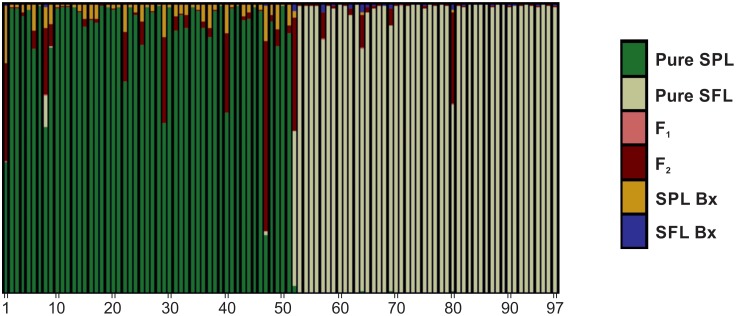
Estimated posterior probabilities that each individual from the sympatric populations of L. planeri (SPL; n = 52) and L. fluviatilis (SFL; n = 46) belongs to each of the six different genotype frequency categories that arise from two generations of potential interbreeding (parental species, F1, F2 and backcrosses), computed by NewHybrids.Each individual is represented by a vertical bar. For the individuals identified as belonging to a certain hybrid category, posterior probability values are detailed in Table 5.